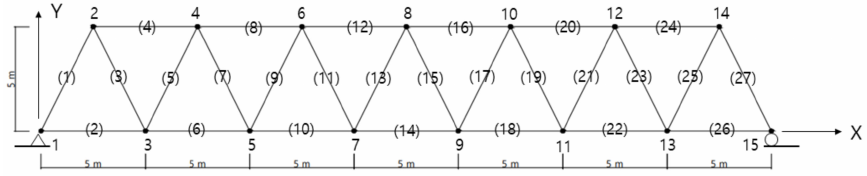
Figure 2. A plane truss (The number in the bracket indicates the